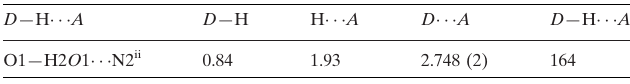
Hydrogen-bond geometry (A˚ , (cid:3)